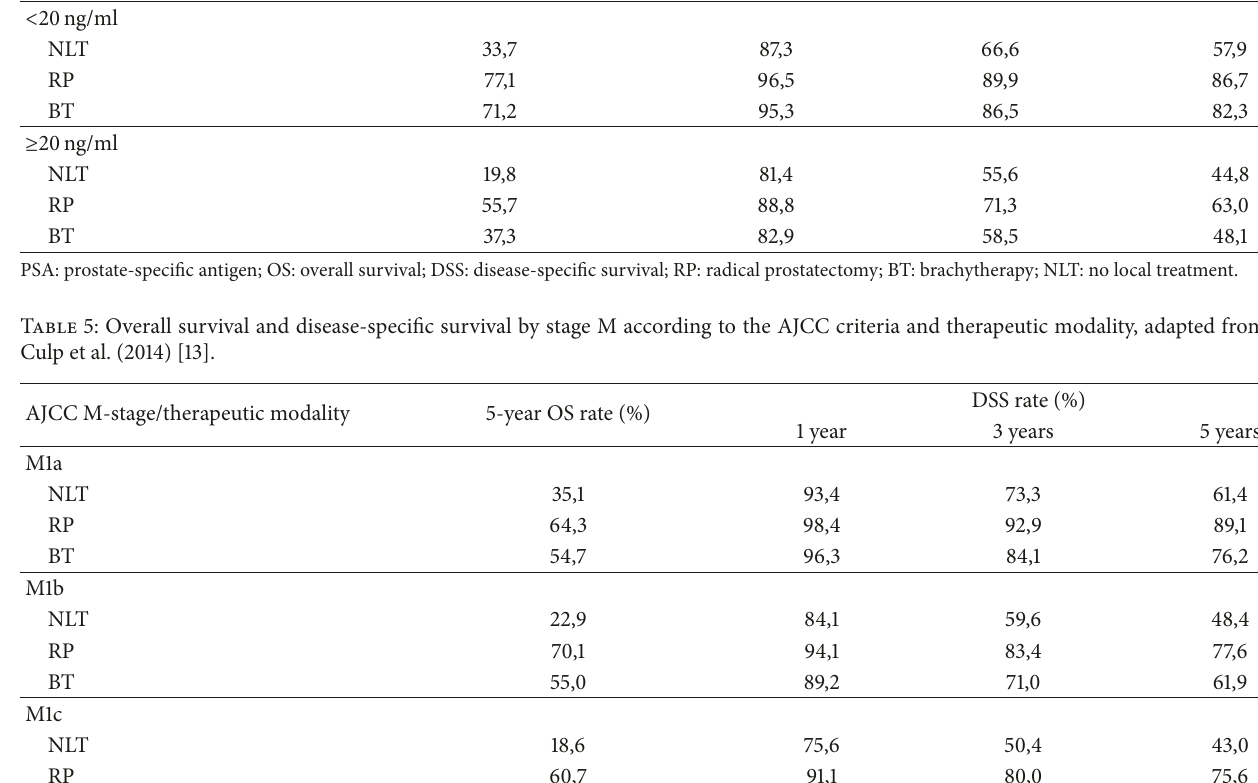
Table 4: Overall survival and disease-specific survival by PSA and therapeutic modality, adapted from Culp et al. (2014) [13]. PSA/therapeutic modality